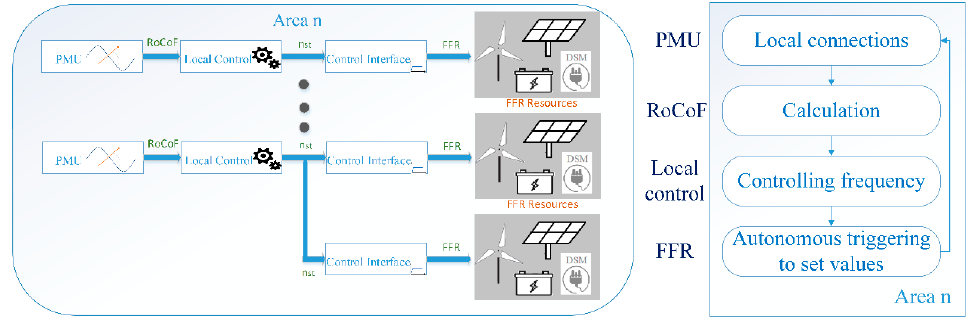
Figure 7. Overview of FFR control scheme and the diagram flow of the novel approach implementation.